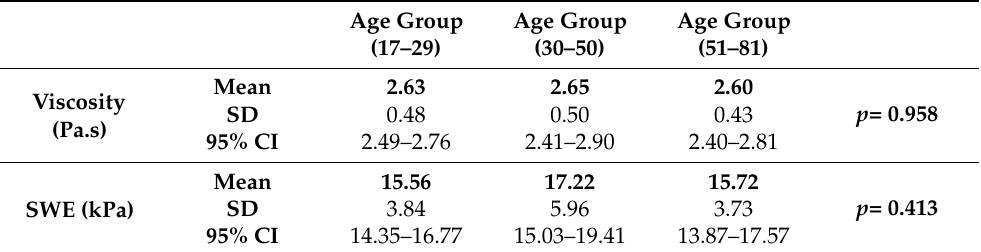
Table 5. Mean viscosity and stiffness values of the thyroid parenchyma in healthy volunteers group based on the age distribution.